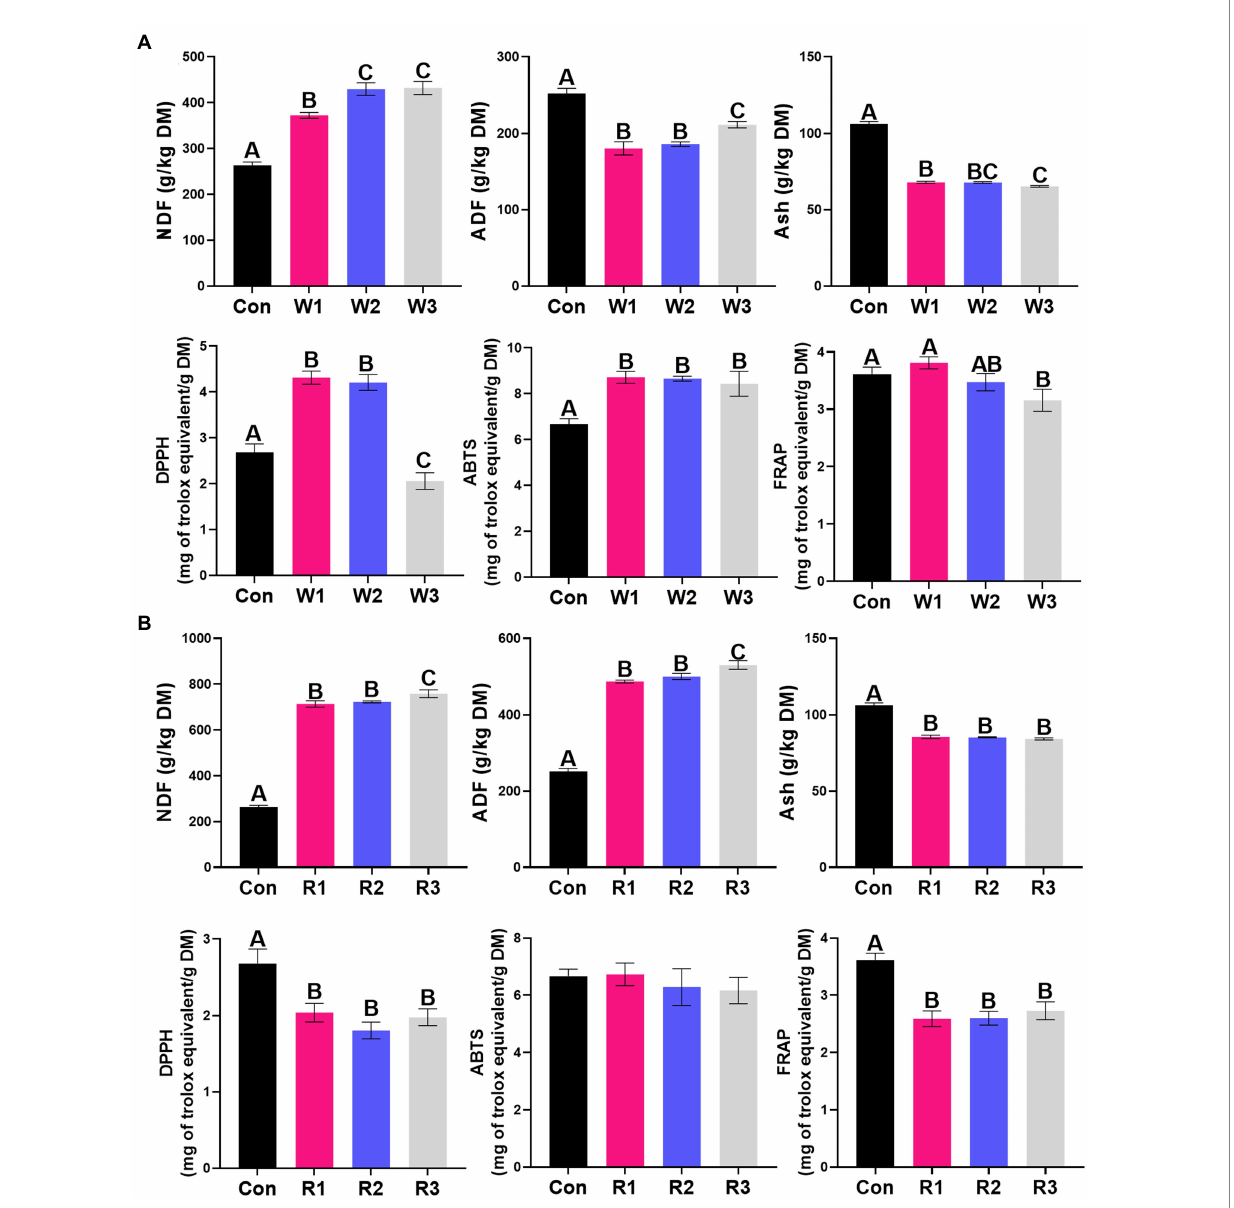
FIGURE 3 Chemical composition and antioxidant activity (A,B) during the anaerobic fermentation of Chinese cabbage waste. The control group (Con). Chinese cabbage waste was mixed with wheat bran at a mass ratio of 383:117 (W1), 353:147 (W2), and 323:177 (W3) or with rice bran at 387:113 (R1), 358:142 (R2), and 329:171 (R3), respectively; NDF, neutral detergent fiber; ADF, acid detergent fiber; Ash, crude ash; DPPH, free radical DPPH scavenging activity; ABTS, radical ABTS scavenging activity; FRAP, ferric reducing antioxidant power. The significant difference ( p < 0.05) between different groups is represented by the different capital